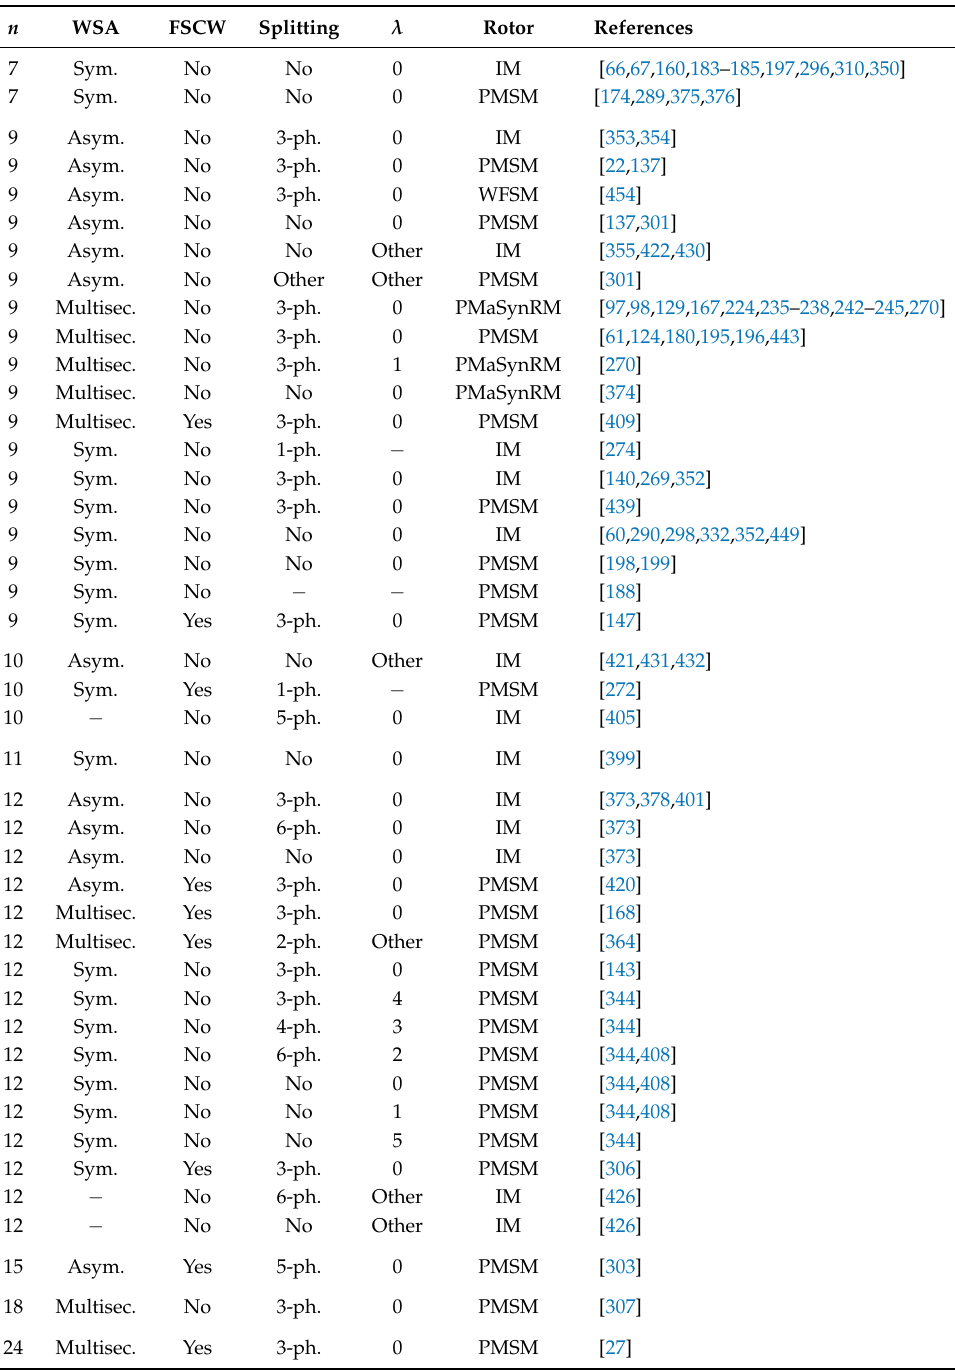
Table 5. Classification of references about fault tolerance in multiphase drives according to the type of machine and stator configuration (Section 3.1), for n ≥